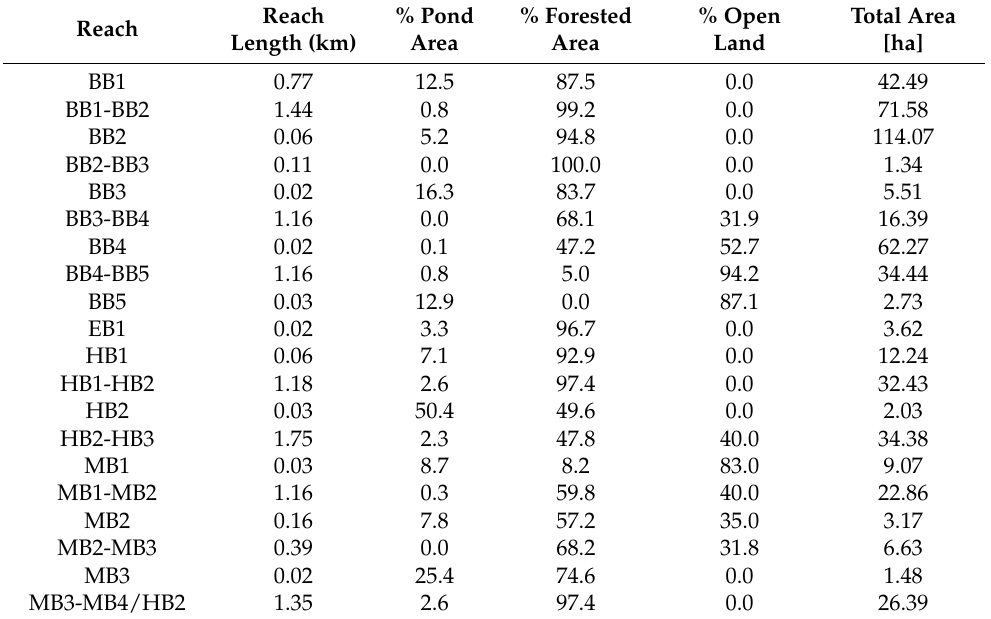
Table 6. Proportion of different LU categories within the 180 m corridor along the reach between the subsequent monitoring points; reaches are differentiated between short stretches covering the distance between monitoring points upstream and downstream of a channel inflow (site X) and longer stretches covering the distance between two subsequent monitoring points (point X–point X + 1); within a sampling site, this refers to the reach between ‘us’ and ‘ds’ monitoring points; between sampling sites, this refers to the reach between ‘ds’ point of the upstream and ‘us’ point of the subsequent site. Reach % Reach Length (km)